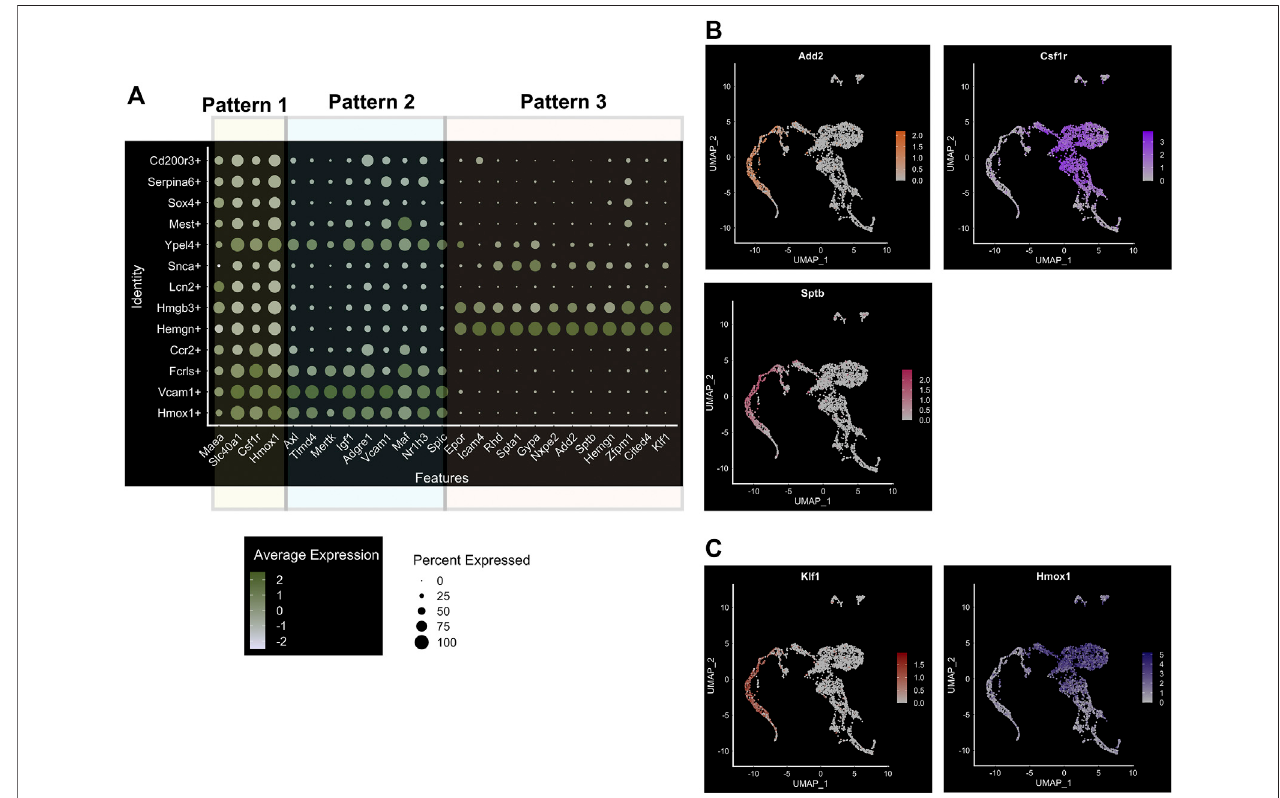
FIGURE 3 | Major subpopulations of mouse E13.5 FL macrophages. (A) Bubble-plot showing speci fi c genes expressed in the three major superclusters of FL macrophages, including population-speci fi ctranscriptionfactors. Three patterns are segregated asindicated, based on their common expression asexpanded upon in thetext. (B) Featureplotshowingcell-surfacemarkerexpressionassociatedwiththesuperclusters3and1, Sptb/Add2 and Csf1r ,respectively. (C) Featureplotshowing EKLF/ Klf1 expression; compare to positive overlap with Sptb/Add2 in supercluster 3 (shown in (B) ), but lack of overlap as compared to the cell-surface marker expression associated with supercluster 1, Hmox1